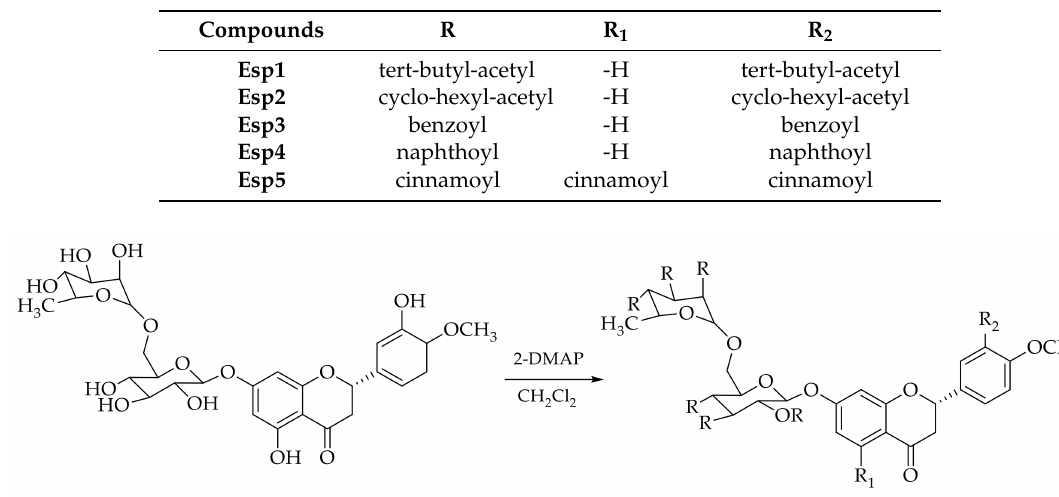
Table 2. Synthetic derivatives of hesperidin.